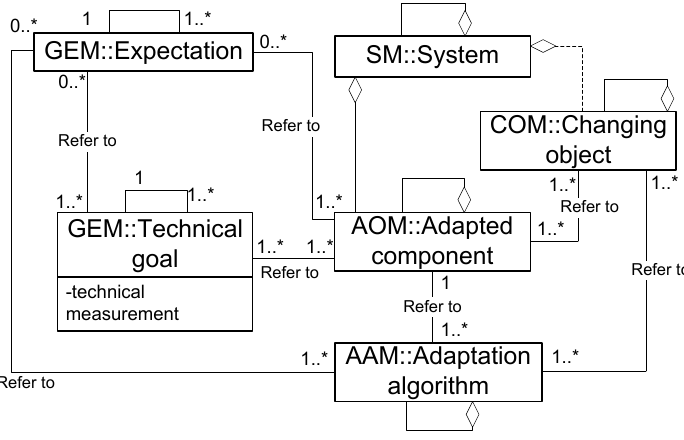
Figure 6. Adapted component’s concept in the